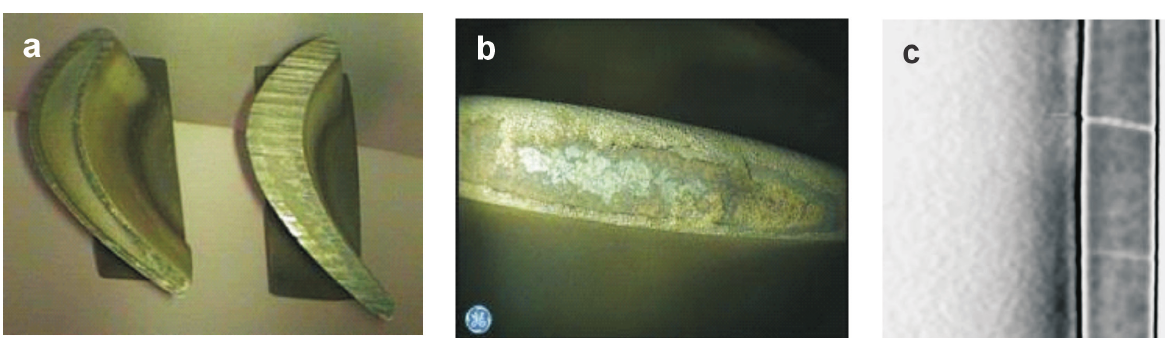
Fig. 1. Example forms of damage to gas turbine blades: a) the turbine blade tip chafing and its wear, b) total burn out of the coating until the leading edge alloy is revealed, c) the turbine blade leaf tomogram with a visible crack inside the leading edge